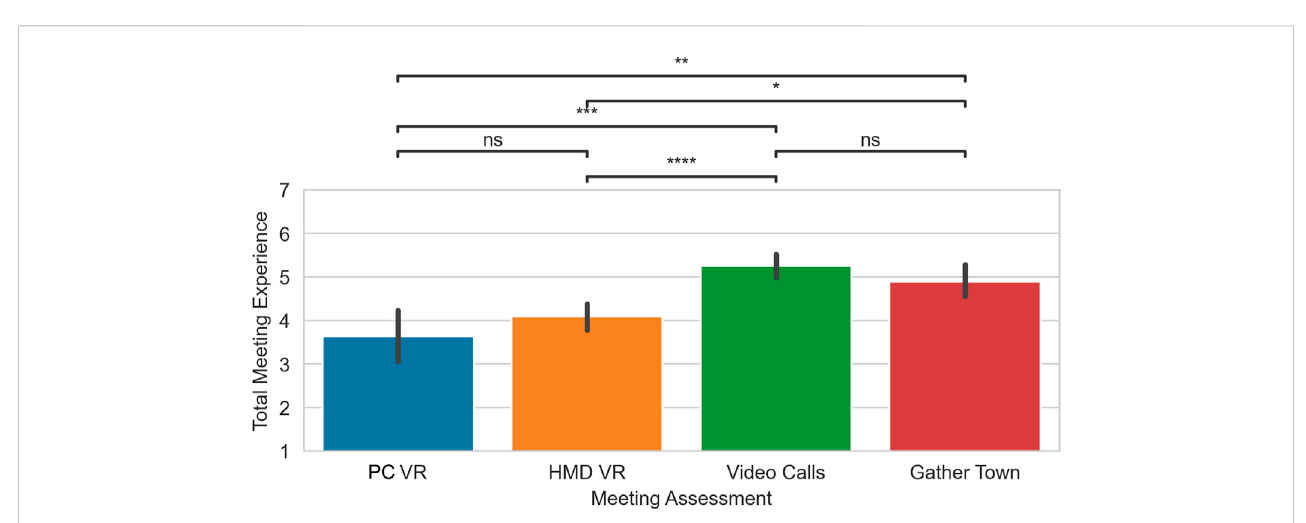
FIGURE 5 Barplot of the total meeting experience assessed in meetings M2 – M12 together with the results of Bonferroni-corrected paired t-tests.